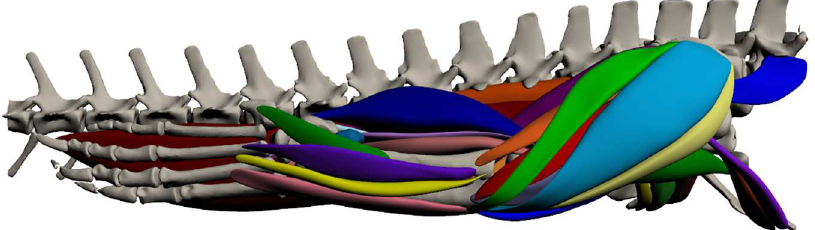
Fig 12. Three-dimensional model of hindlimb musculature in Crocodylus porosus . Lateral view of the right hindlimb. The interactive version of this model is availablein ‘Supplementary Information’.